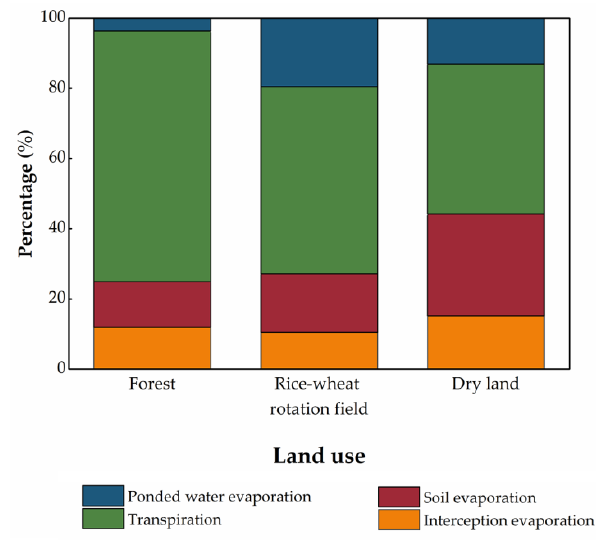
Figure 7. Average proportion of evapotranspiration partitioning with three types of vegetation (2000–2013).